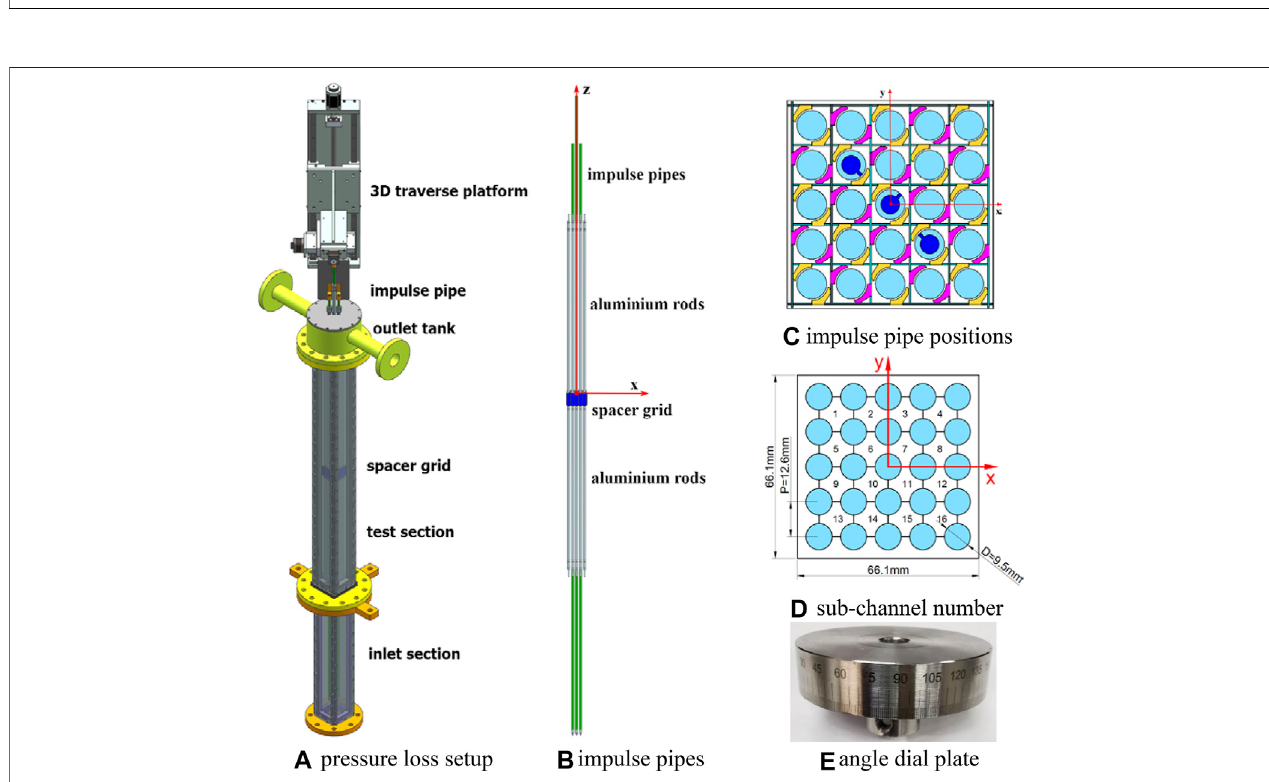
FIGURE 2 | Pressure loss measurement system.